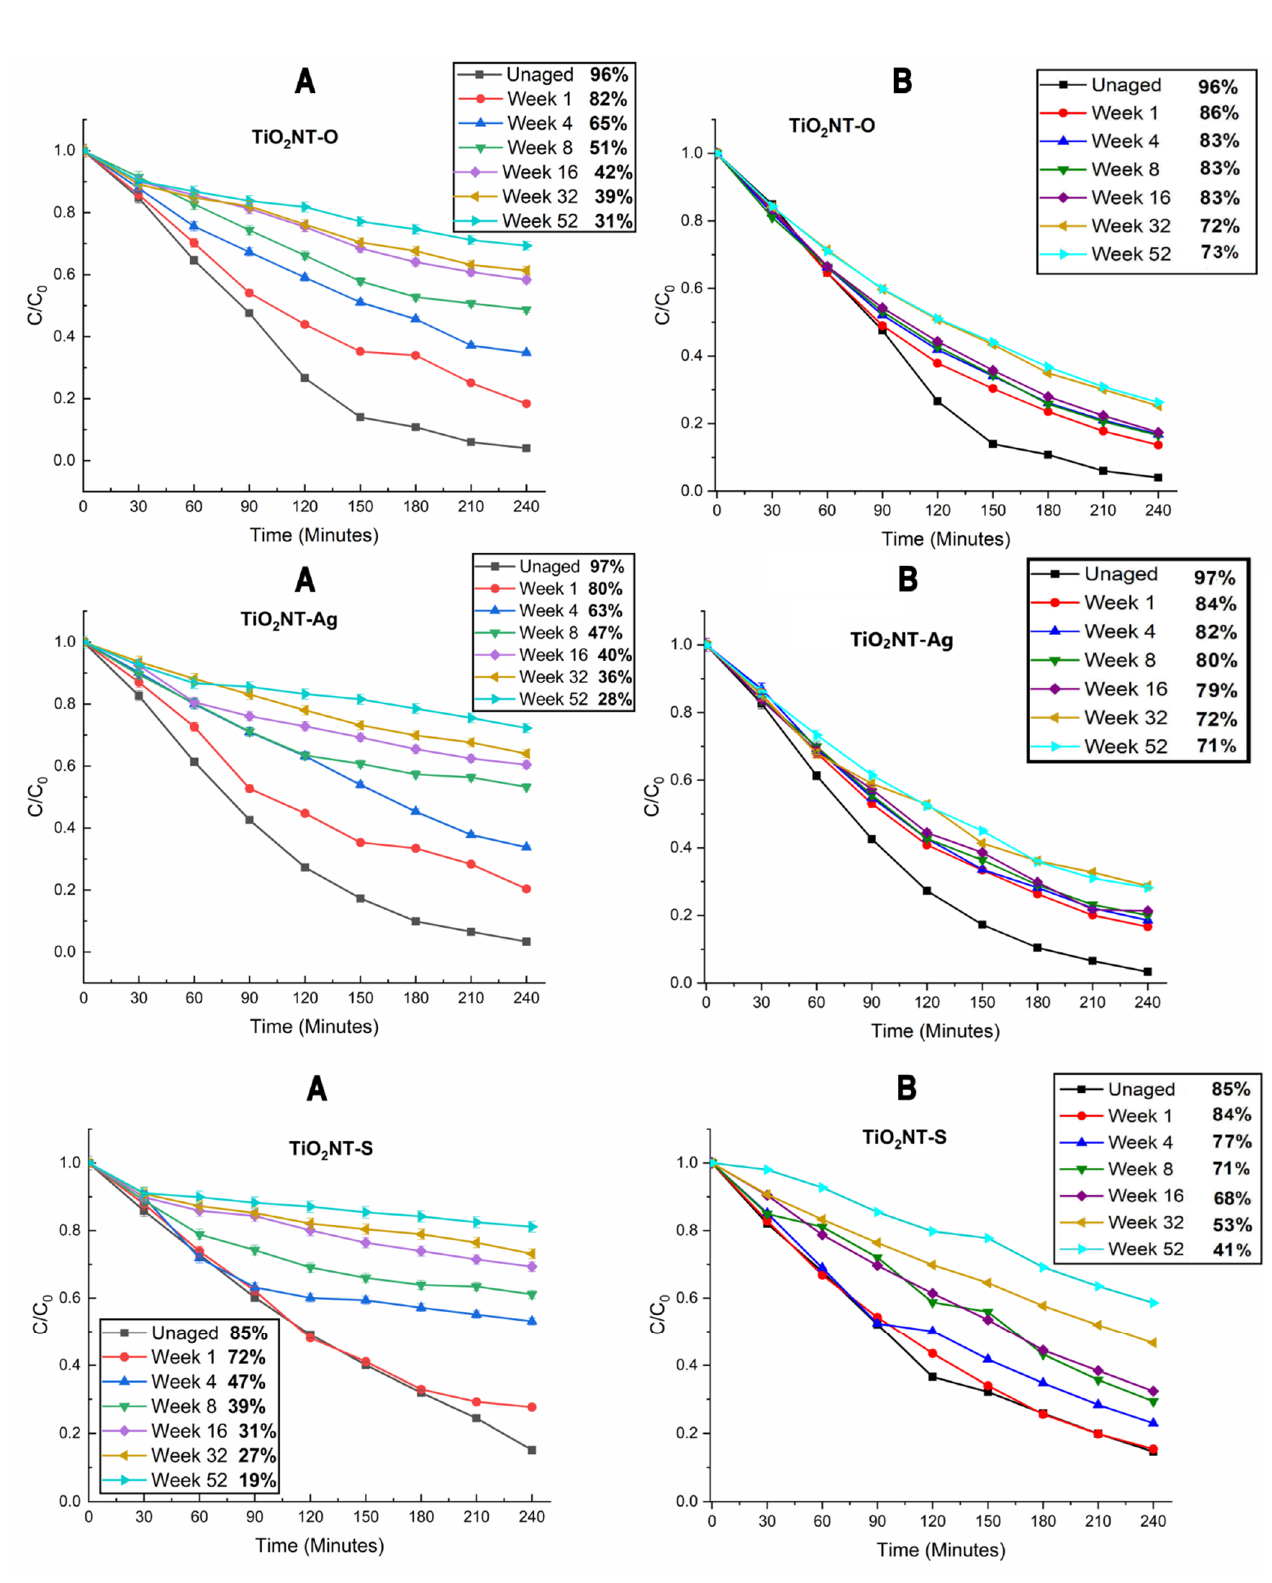
Figure 10. Methylene blue dye reducing tests conducted on the as-collected samples ( A ) and samples dried for 3 months ( B ).